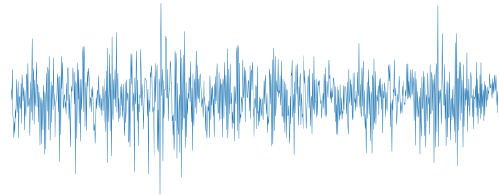
Figure 1. Image of time-domain input